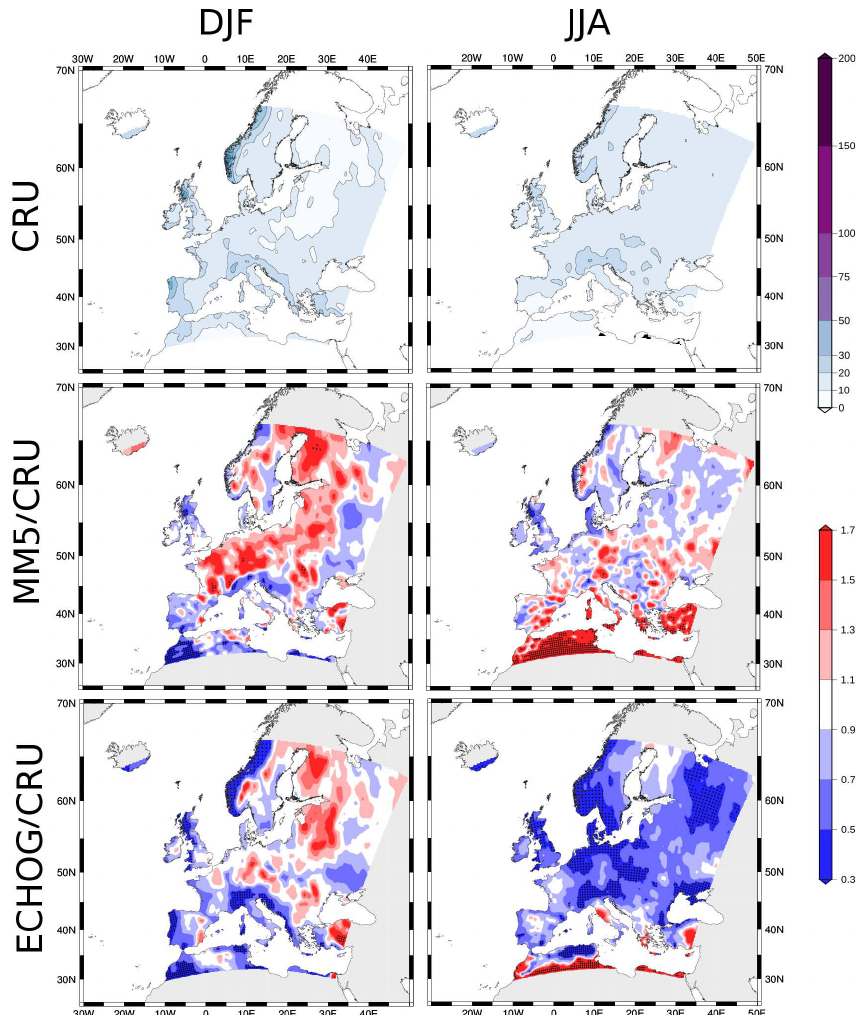
Fig. 7. Standard deviation of seasonal precipitation series (in mmmonth − 1 ) for the 1960–1990 period in winter (left panels) and summer (right panels) in CRU (top panels). Panels below show the ratio between MM5 driven by ECHO-G and CRU (middle panels) and ECHO-G alone and CRU (bottom panels). To perform the calculations, all datasets are spatially interpolated onto the MM5 grid, and only non-ocean grid cells are considered. The significance of the differences are tested through a two-tailed T test at the 95% confidence level and it is indicated with small black circles in the